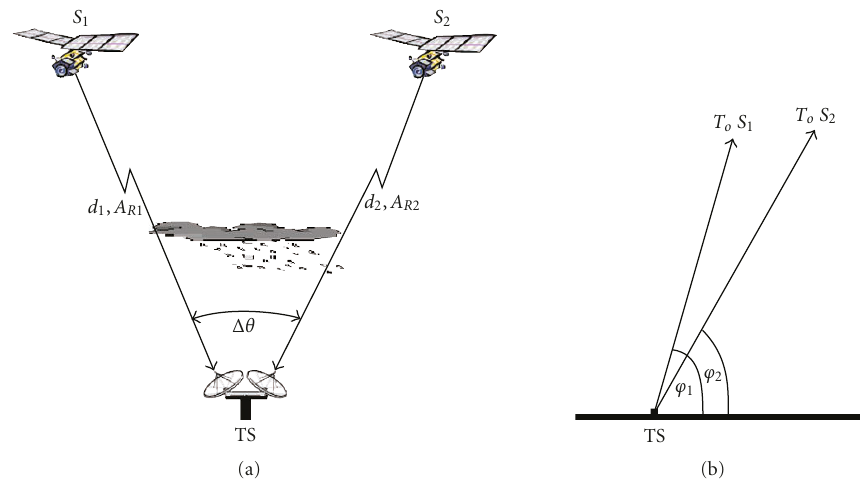
Figure 1: (a) Configuration of a dual-satellite 2 × 2 MIMO channel. Individual satellites S 1 and S 2 transmit either independent data streams (MIMO spatial multiplexing system, Section 3) or the same signal over the multiple (ideally) independently fading paths (MIMO diversity system, Section 4), (b) associated elevation